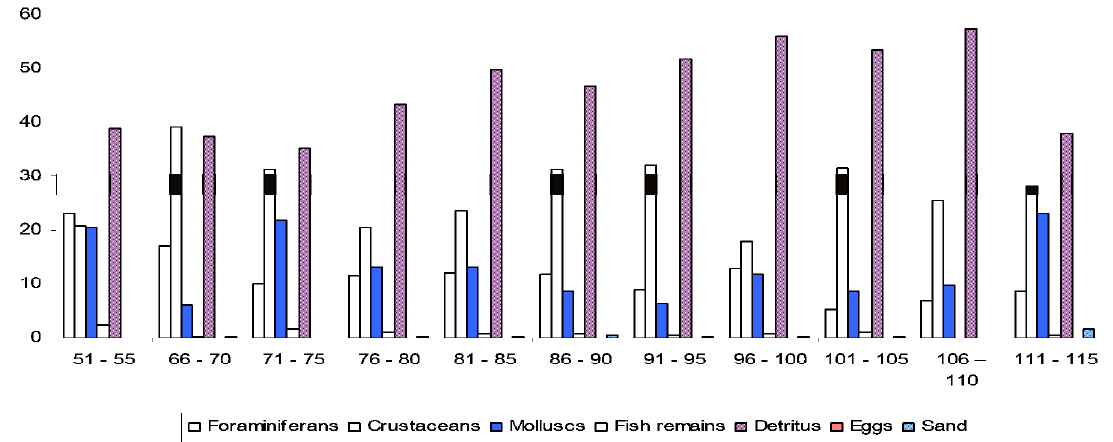
Fig. 6. Diet composition in different size-groups of females of S. melantho